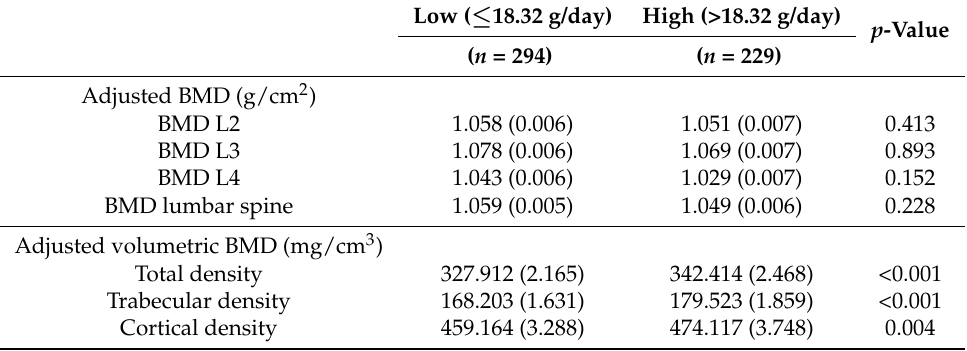
Table 2. Lumbar BMD and volumetric bone mineral density (vBMD)after further adjustment by potential confounders *.